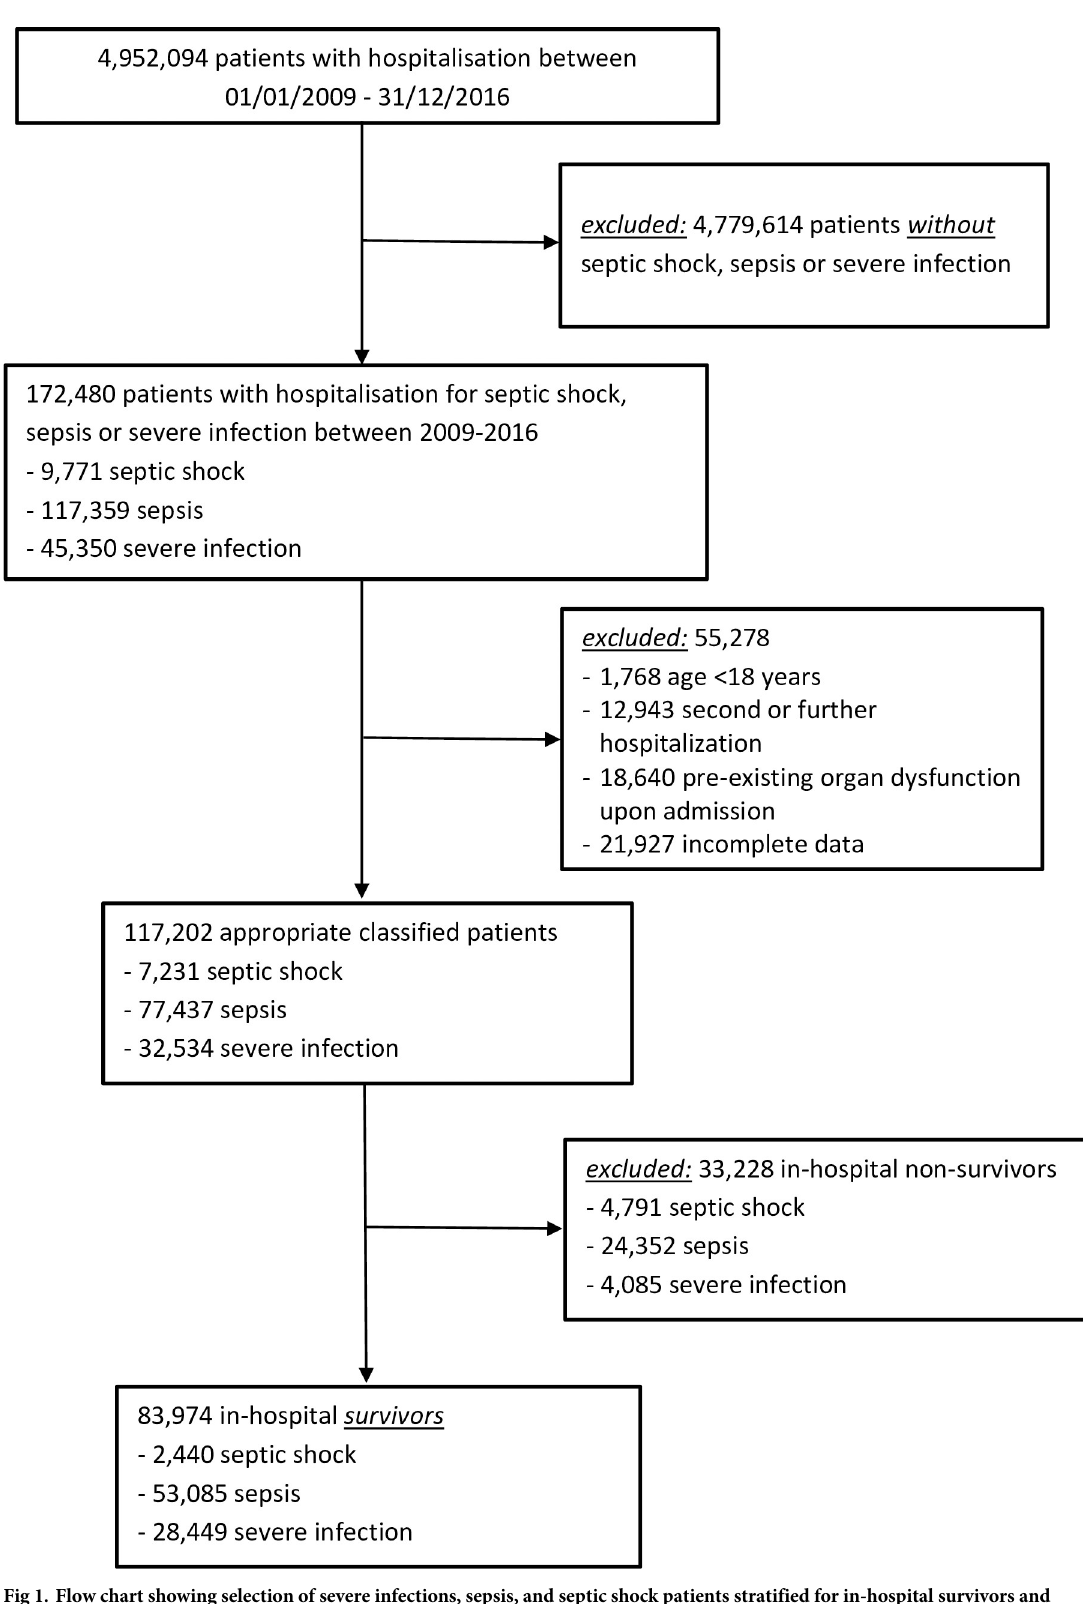
Fig 1. Flow chart showing selection of severe infections, sepsis, and septic shock patients stratified for in-hospital survivors and non-survivors.